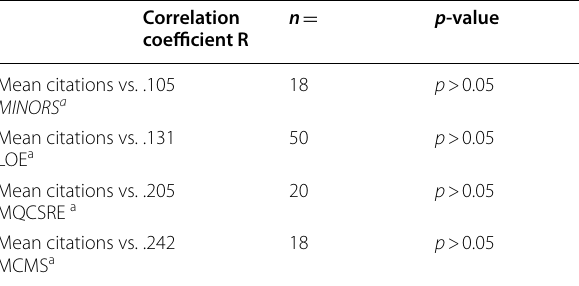
Table 2 Correlation between citation count vs methodological quality scores and Level of evidence. a Modified Coleman methodological Score (MCMS); Methodological Index for Non‑ Randomized Studies (MINORS); Radiologic Methodology and Quality Scale (MQCSRE); Level of evidence